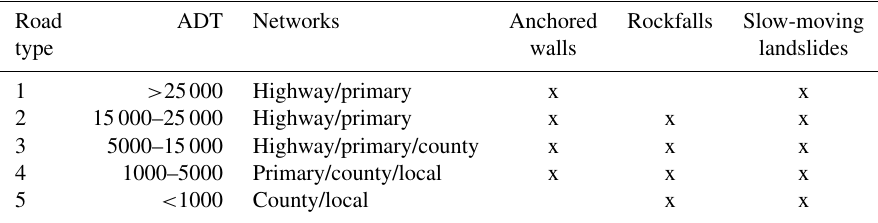
Table 1. Occurrence of geotechnical hazard types at different road types (data source: Department of Mobility and Road Infrastructure of Gipuzkoa).